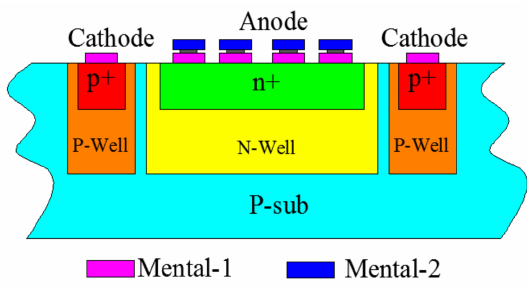
Figure 6. Schematic of the n+/N-Well/P-sub photo-detector.